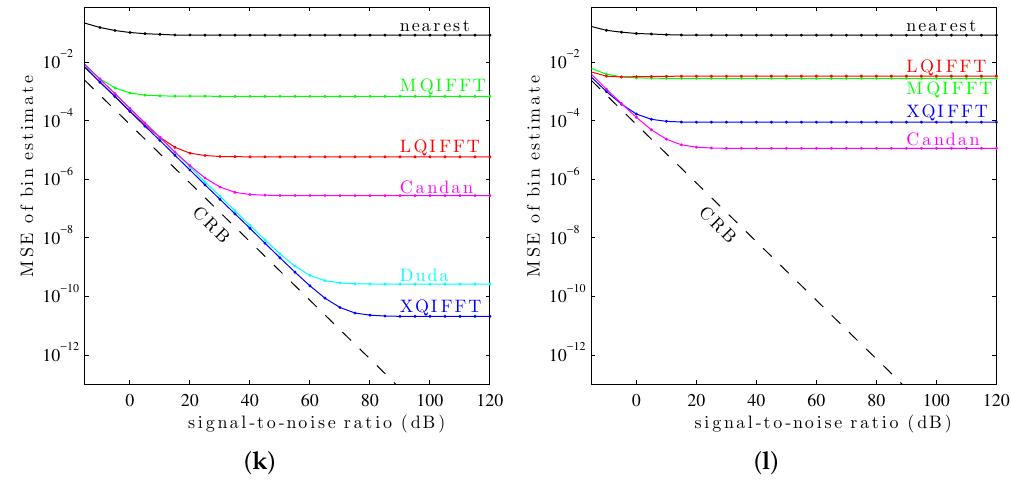
Figure 10. Testing different window types. ( a ) Hann window; ( b ) Bartlett–Hann window; ( c ) Bartlett window; ( d ) Hamming window; ( e ) Blackman window; ( f ) Blackman–Harris window; ( g ) Gaussian window; ( h ) DPSS window; ( i ) Kaiser–Bessel window; ( j ) Nuttall window; ( k ) Chebyshev window; ( l ) Tukey window